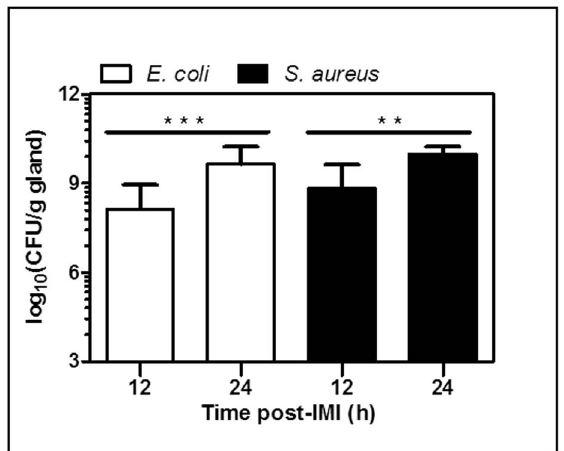
Figure 1. Changes in mammary bacterial counts post-IMI with E.coli or S.aureus . At 12 h and 24 h post-IMI, mammary tissue was harvested and evaluated for bacterial growth. (P , 0.01 **, P , 0.001***)